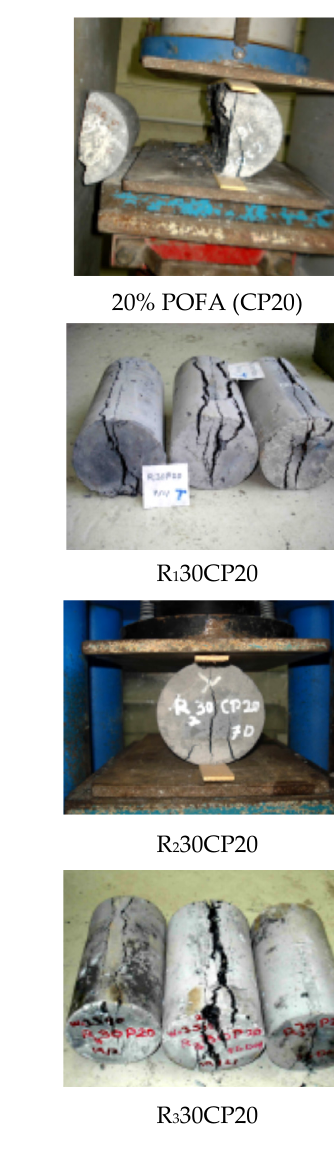
Figure 11. Rubberized concrete sample showing large deformation without disintegration by increas- ing the level of rubber particles in